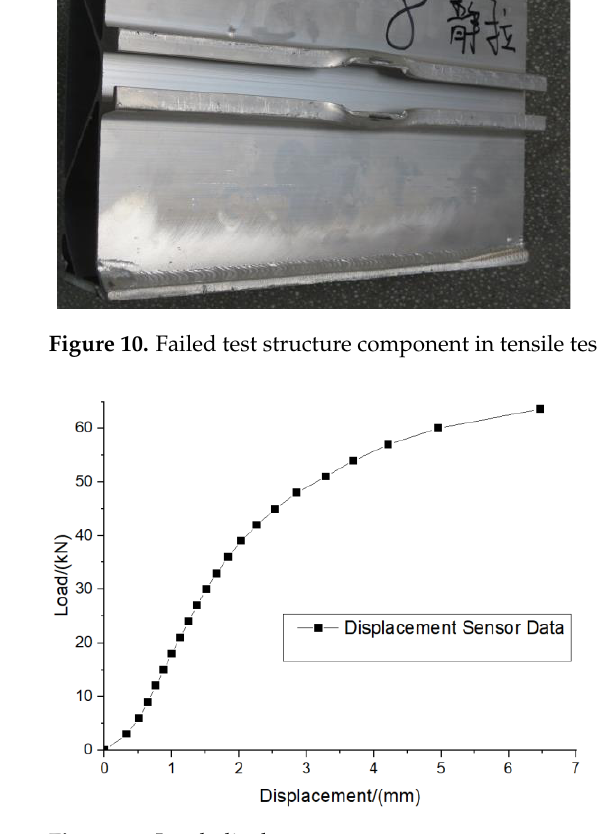
Figure 11. Load – displacement curve. Figure 11. Load–displacement